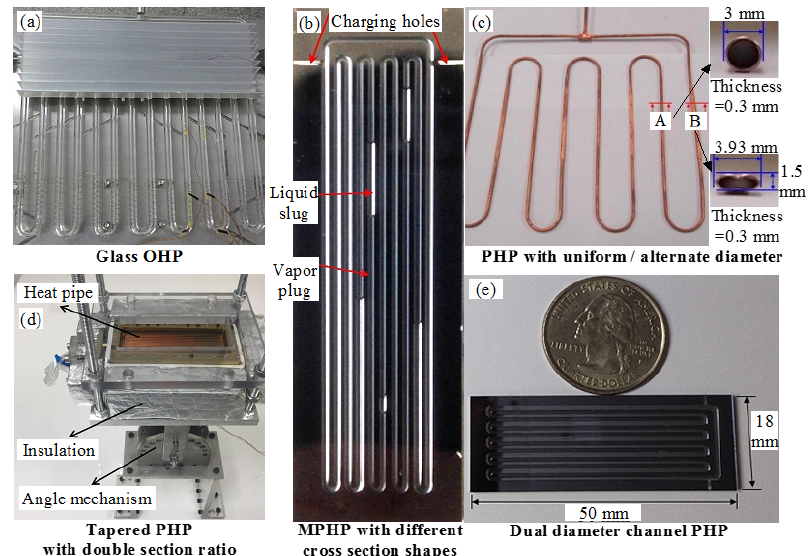
Figure 8. Heat pipe structure with multiple elbows: ( a ) Glass OHP [92]. Qu et al. (2016); ( b ) MPHP with different cross section shapes [94]. Lee and Kim, (2017); ( c ) PHP with uniform/alternate diameter [97]. Tseng et al. (2014); ( d ) Tapered PHP with double section ratio [98]. Markal et al. (2021); ( e ) Dual diameter channel PHP [102]. Kwon et al. (2015).